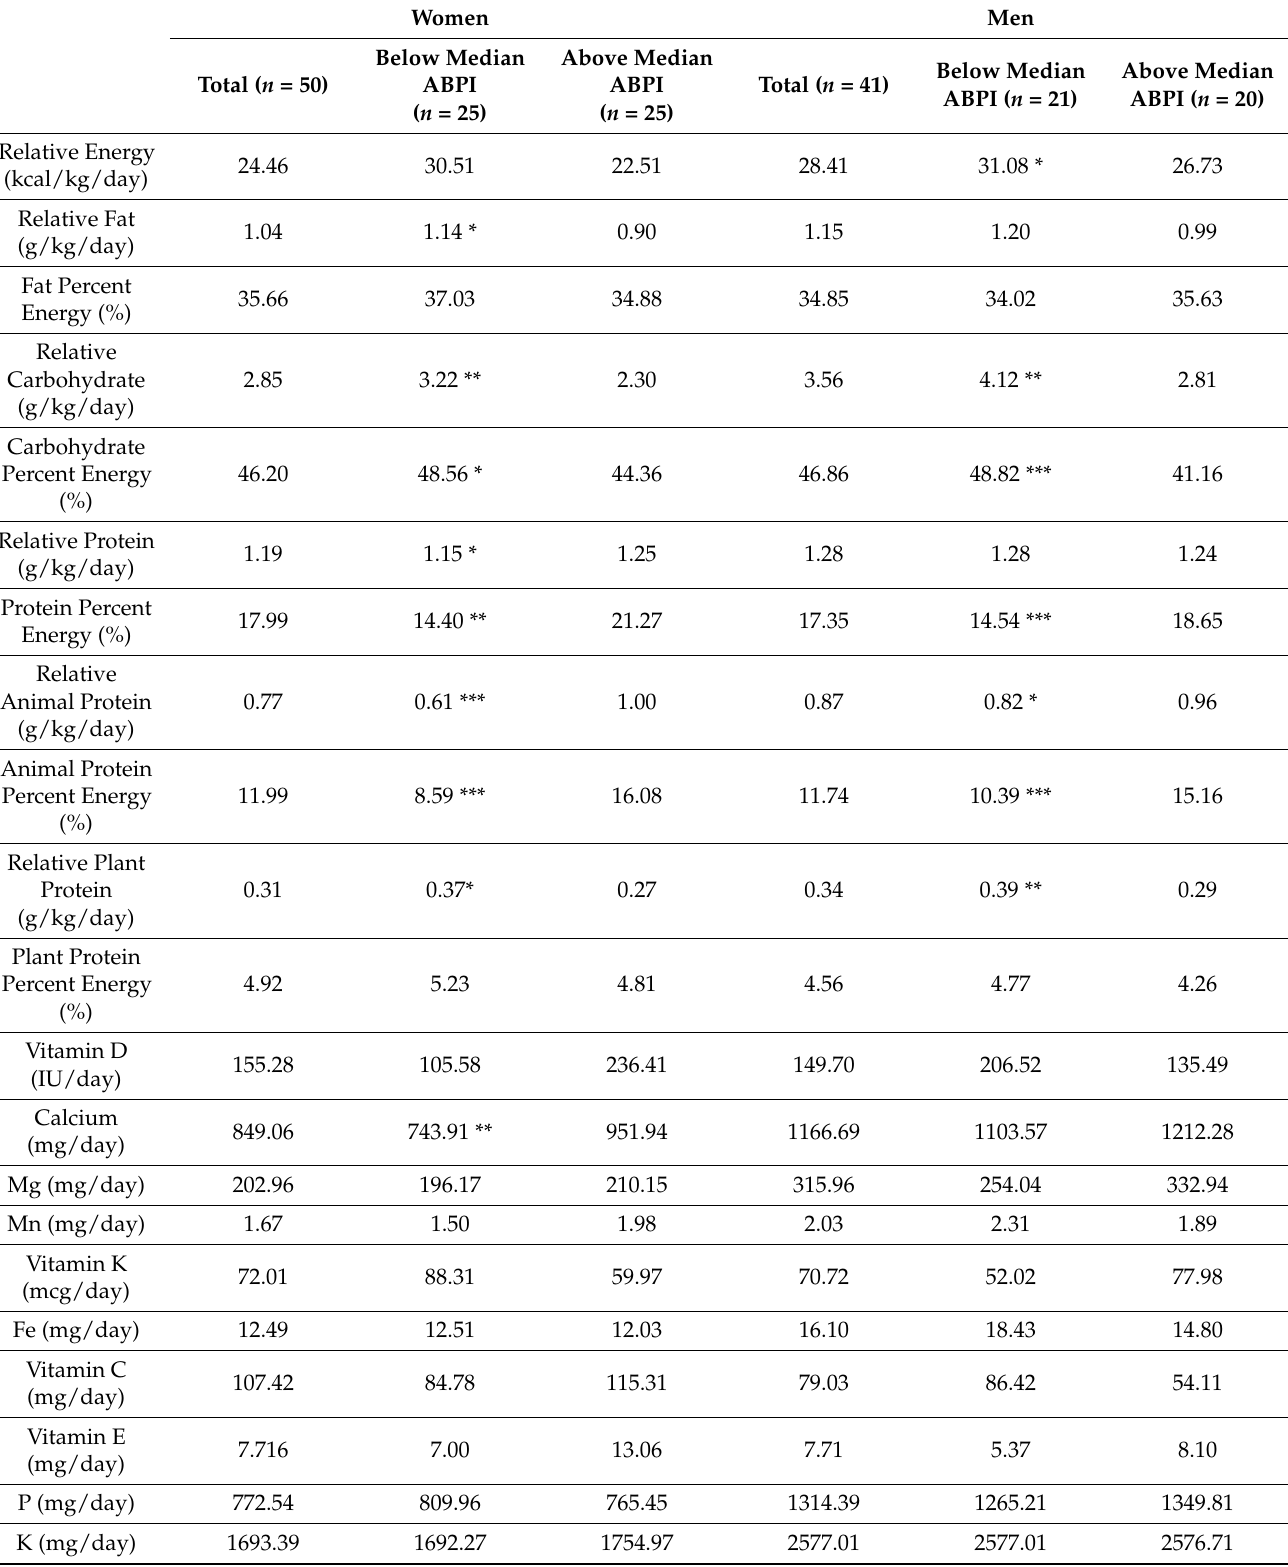
Table 5. Dietary intakes accessed from three-day food diaries in 41 middle-aged men and 50 middle-aged